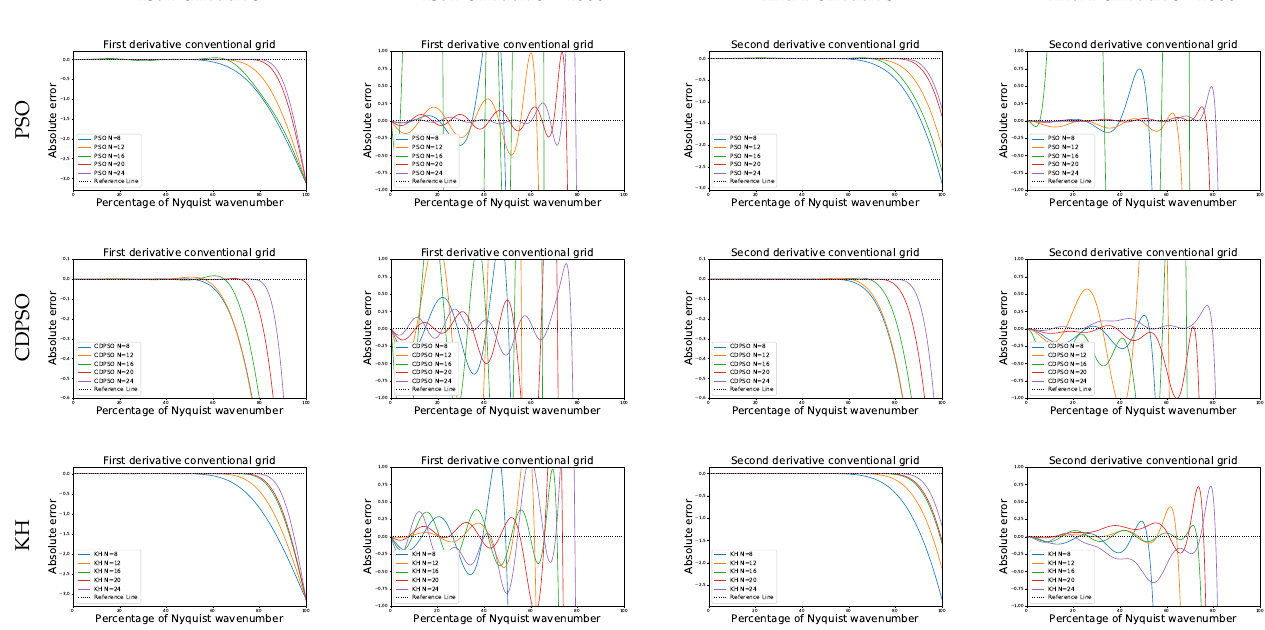
Figure 4. The first and second derivative accuracy of PSO, CDPSO, and KH. The horizontal and vertical coordinates are the percentage of Nyquist wavenumber k x and absolute error E 1 ,